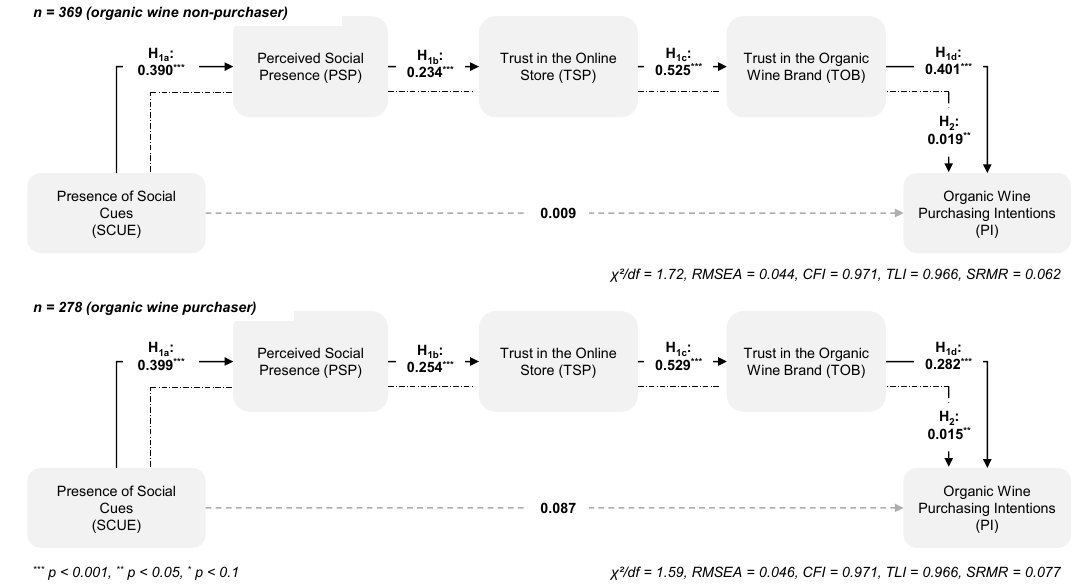
Figure 4. The role of familiarity on the effects of the presence of social cues.